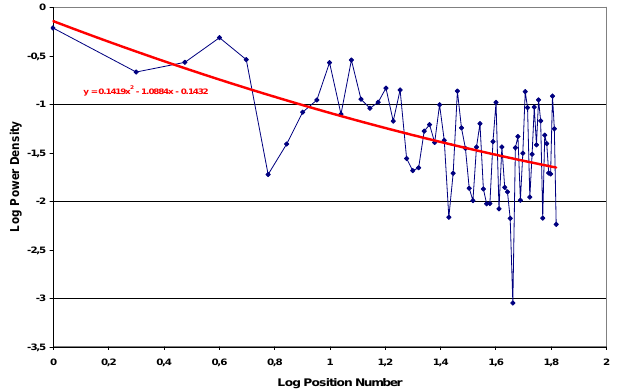
Fig. 26. Periodogram (black diamonds) of 132 TiO 2 concentra- tion values from boreholes in the Black Cargo Titaniferous mag- netite deposit, Los Angeles County, California. Quadratic curve (red curve)was fitted by least squares. The overall pattern is similar to that of Fig. 25 for the Pulacayo zinc